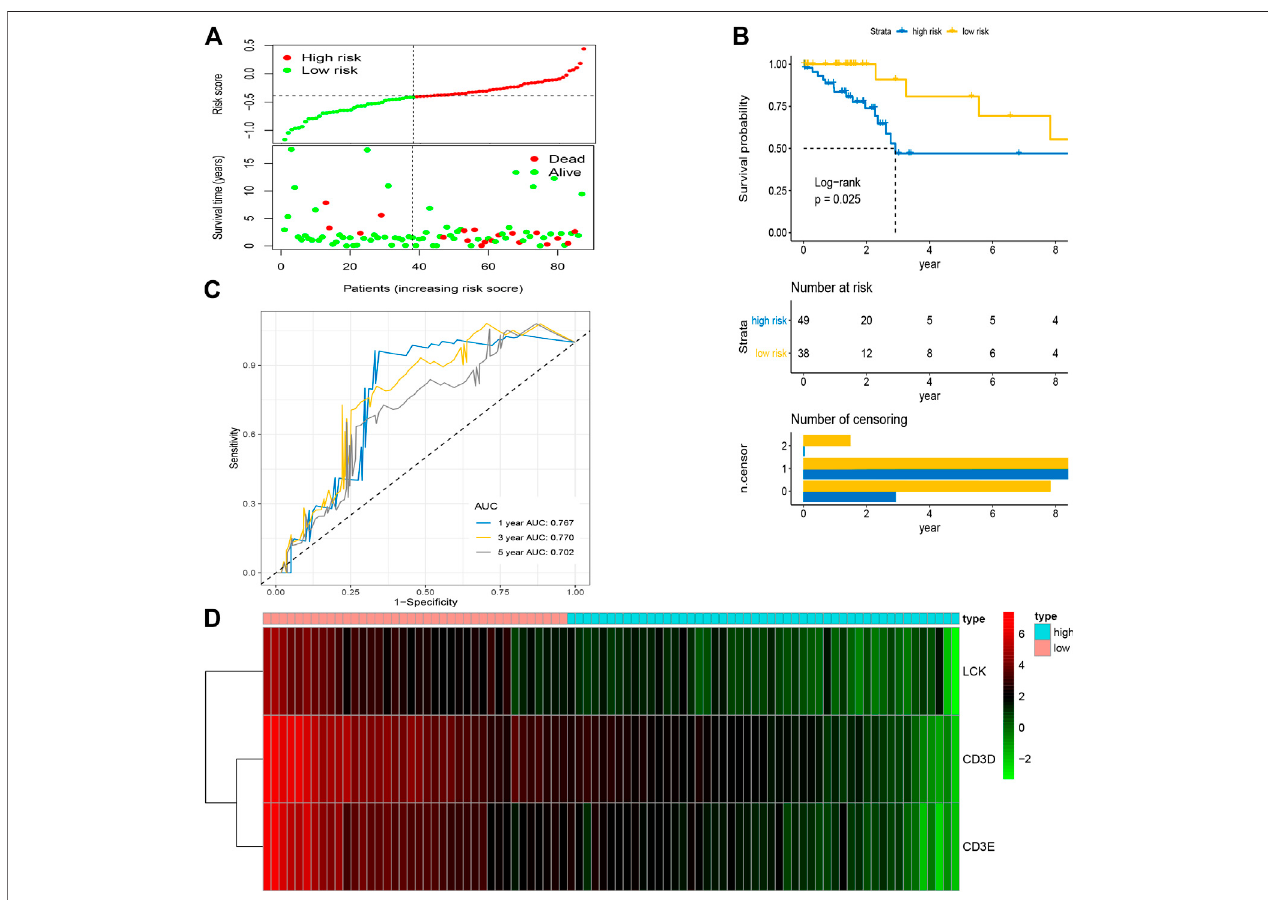
FIGURE 8 | Validation of prognostic signature based on four hub IRGs in testing group. (A) The distribution of risk scores and survival status between low- and high-risk groups, and mean level of risk score was set as the cut-off value. (B) The overall survival analysis of patients in two subgroups. (C) ROC curve analysis for the prediction of1-, 3-, and 5-year OSas the de fi ning point of thefour-hubIRGs signature. (D) Heatmap offour prognostic IRGs. IRGs, immune-related genes; ROC curve, receiver operating characteristic curve; OS, overall survival.